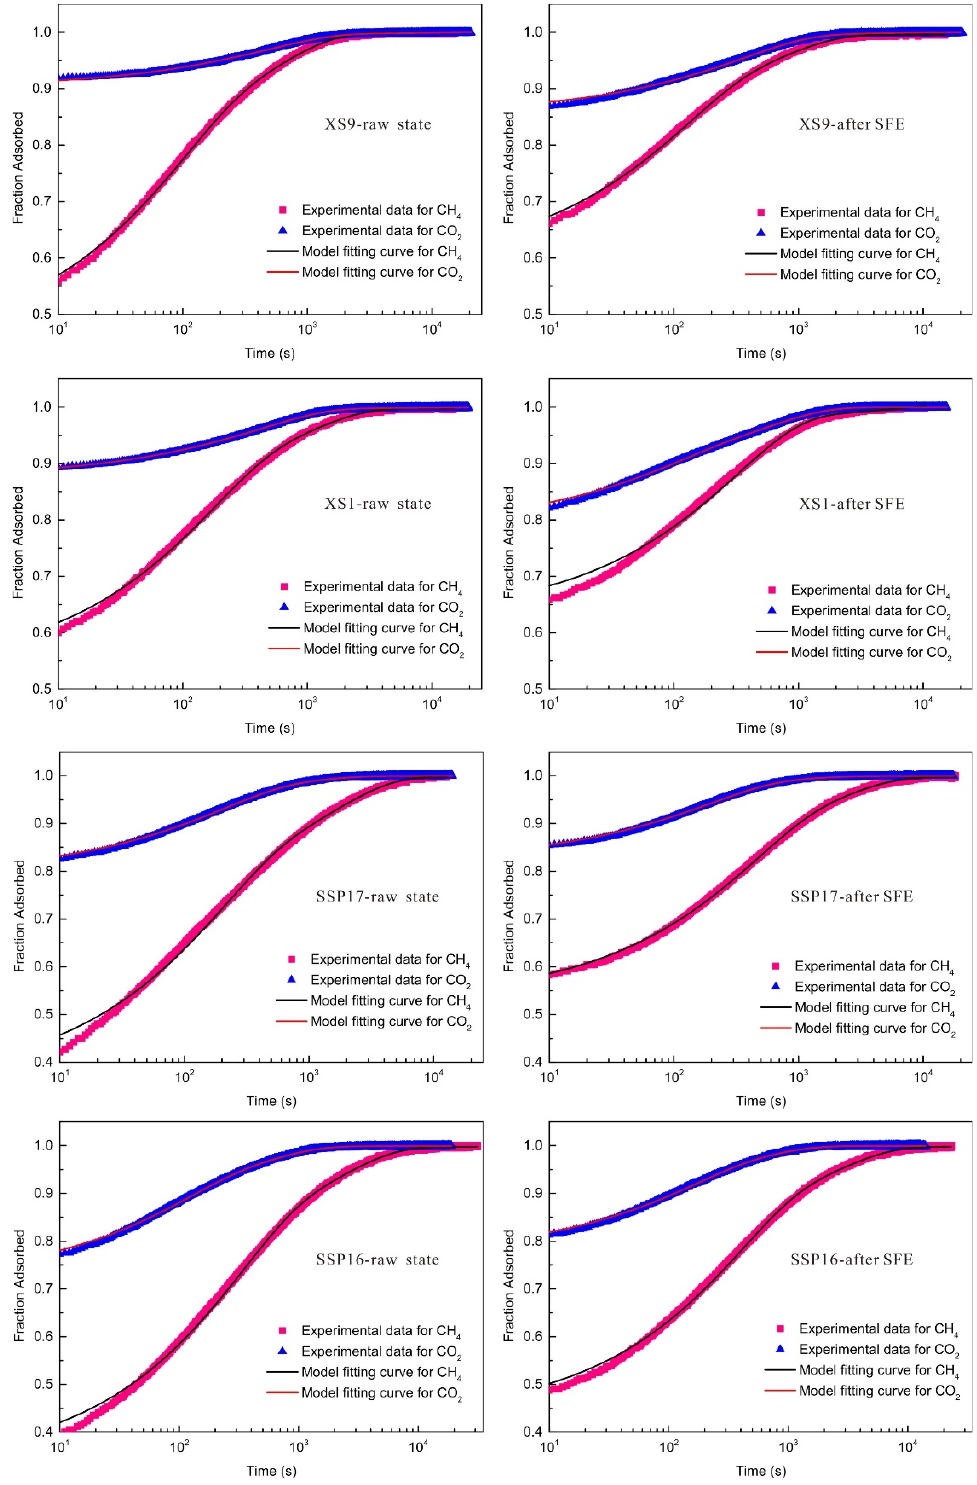
Figure 3. Experimental and fitting curves of CH 4 and CO 2 adsorption rate in samples.